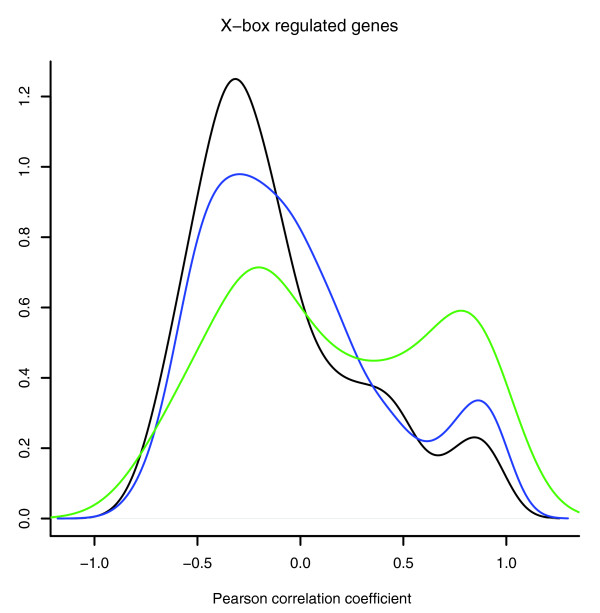
The candidate gene dataset (Additional data file 2) is enriched with genes whose SAGE tag expression profile positively correlates with that of daf-19. 'Random genes' (black line) represents the correlation profile in gene expression between daf-19 and a random set of 1,000 genes in C. elegans; 'before filtration' (blue line) represents the correlation profile between DAF-19 and a raw list of genes that contain all putative X-box motifs in their promoters; and 'after comparative filtration' (green line) represents the correlation profile between DAF-19 and the set of filtered genes that contain X-box motifs in orthologous genes in three Caenorhabditis species.